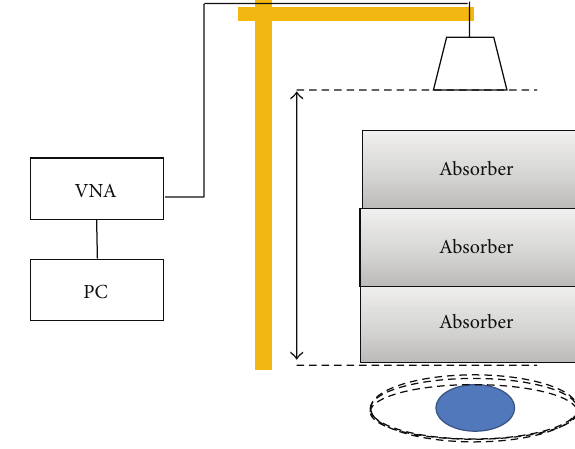
Figure 5: Experimental setup for breathing